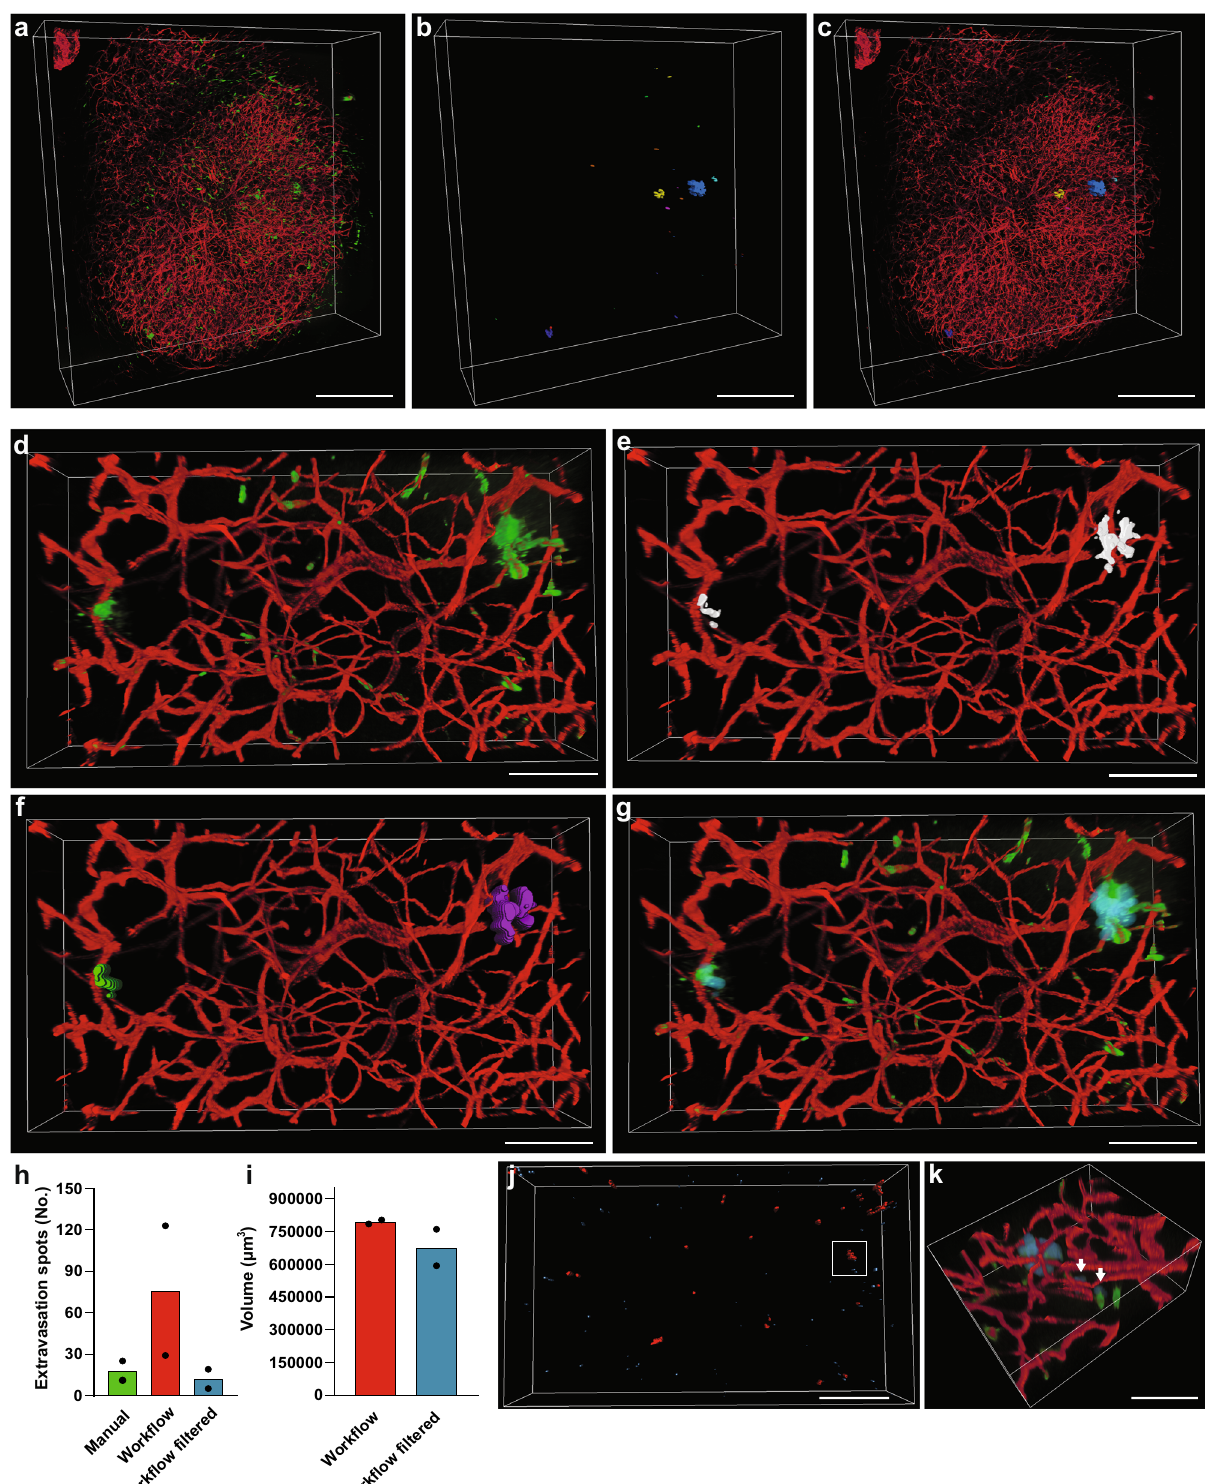
(Supplementary Fig. 10h, i). Vasculature analysis allowed us to detect and quantify differences between the two subsets on such parameters, as volume fraction, mean vessel diameter, and percentage of the vascular volume distribution between vessels with different diameters (Supplementary Fig. 10j, l, m). No apparent differences were seen in mean segment length, number of branching points, and vessels tortuosity (Supplementary Fig. 10k, n, o).